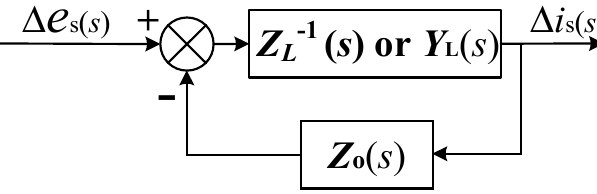
Figure 13. Block diagram of vehicle–grid cascade closed-loop system.